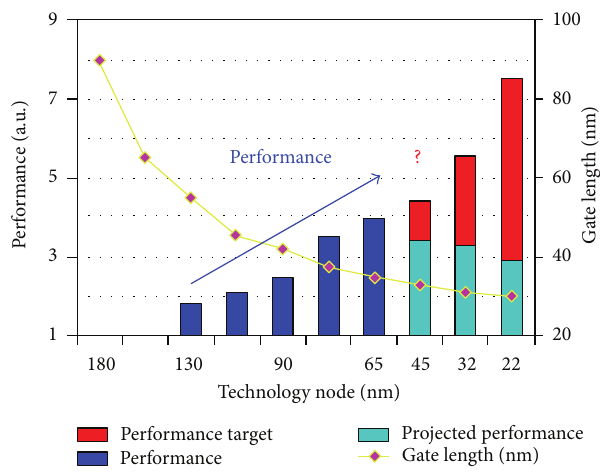
Figure 2: Performance demand of processor